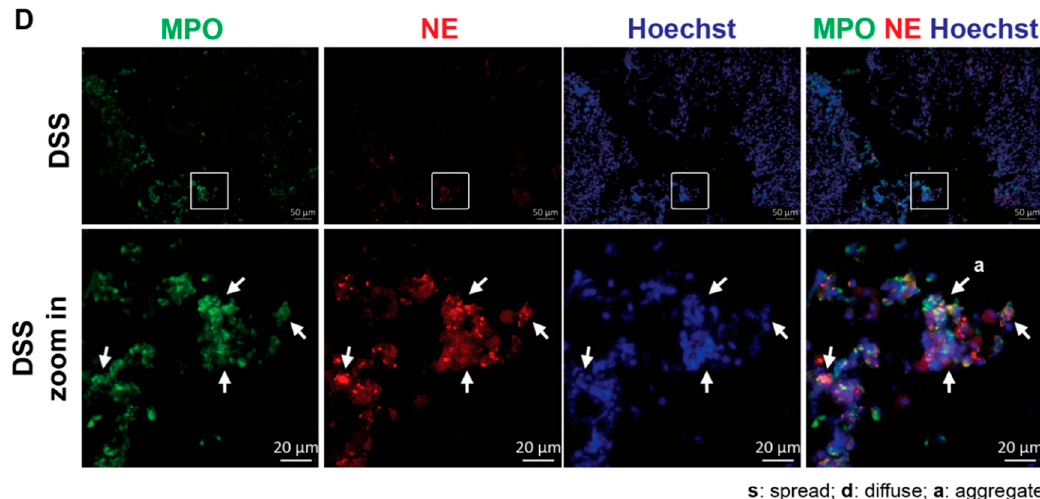
Figure 1. Neutrophil extracellular traps (NETs) are induced in the colon of dextran sulfate sodium (DSS)-treated mice. ( A ) NET release was measured in colon homogenates of wild-type C57BL / 6 mice 8 d after the consumption of clean water or 2.5% DSS, by using myeloperoxidase (MPO)-DNA ELISA. (The results are pooled data from two separate experiments. n = 9 mice per group.) ( B , C ) NET formation counts per 200X high-power field (HPF) and representative NET release (white arrows) in the colon of wild-type C57BL / 6 mice 8 d after the consumption of clean water or 2.5% DSS, assessed by immunofluorescence microscopy of MPO (green), citrullinated histone H3 (citH3; red), and Hoechst 33342-stained DNA (blue). Bottom row, enlargement of the area outlined in the second-row images. (The results are pooled data from two separate experiments. n = 9 mice per group.) ( D ) Representative NET release (gray arrows) in the colon of wild-type C57BL / 6 mice 8 d after the consumption of 2.5% DSS, assessed by immunofluorescence microscopy of MPO (green), neutrophil elastase (NE; red), and Hoechst 33342-stained DNA (blue). Bottom row, enlargement of the area outlined in the second-row images ( n = 9 mice per group). s: NETs in spread form, d: NETs in di ff use form, a: aggregate NET. The data represent the mean ± SEM. Statistical analyses were performed using unpaired, two-tailed t -test. ** p < 0.01, **** p < 0.0001. Scale bars, 50 µ m. 20 µ m in zoom in